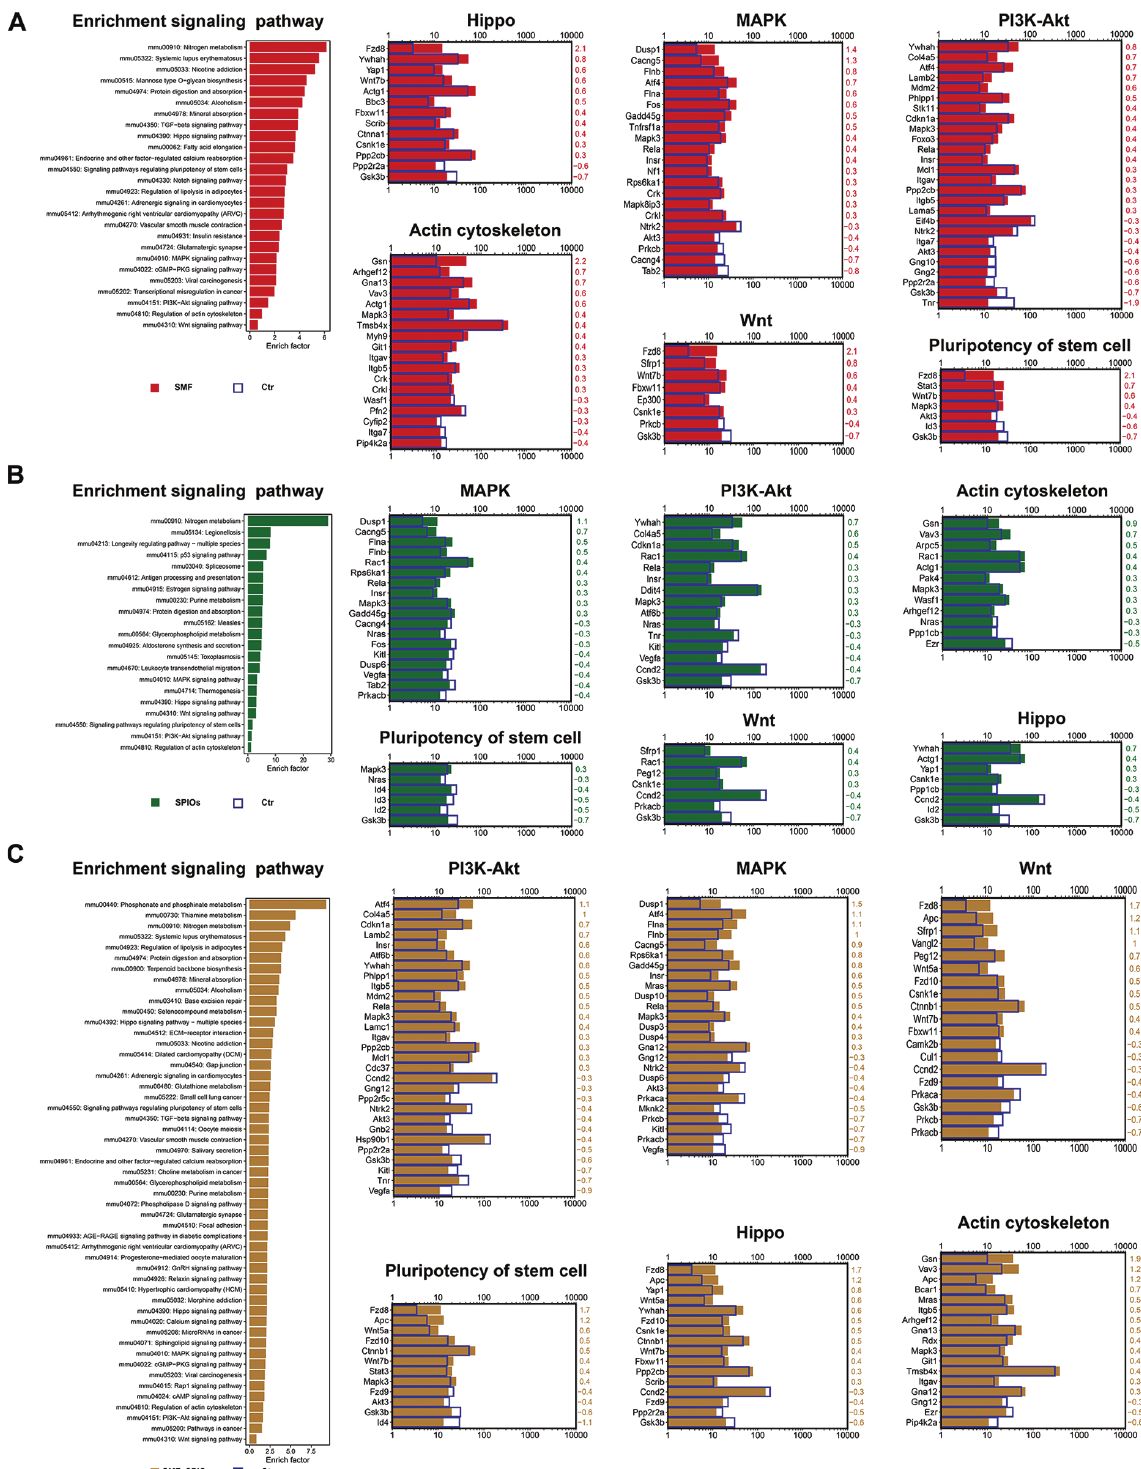
Fig. 6 Signaling pathway gene expressions of NSCs in different culture condition groups. (A) The differential KEGG pathways from NSCs cultured in the SMF group versus NSCs of control. (B) The differential KEGG pathways from NSCs cultured in SPIOs group versus NSCs of control; (C) The differential KEGG pathways from NSCs cultured in the SMF and co-incubated with SPIOs group versus NSCs of control. The red bars represent the gene expression levels of NSCs cultured in the SMF group. The green bars represent the gene expression levels of NSCs cultured in the SPIOs group. The yellow bars represent the gene expression levels of NSCs cultured in the SMF + SPIOs group. The blue bars represent the gene expression levels of NSCs cultured in the control